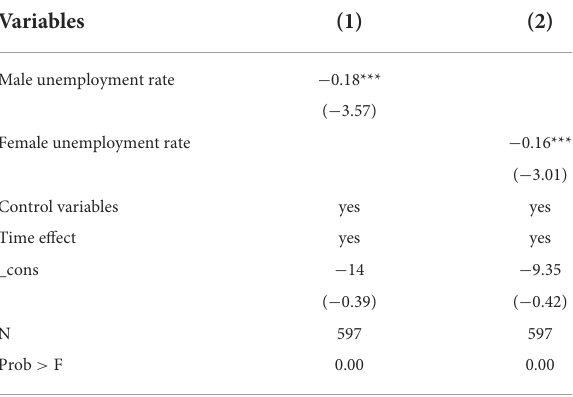
TABLE 6 Impact of gender-specific unemployment rates on economic